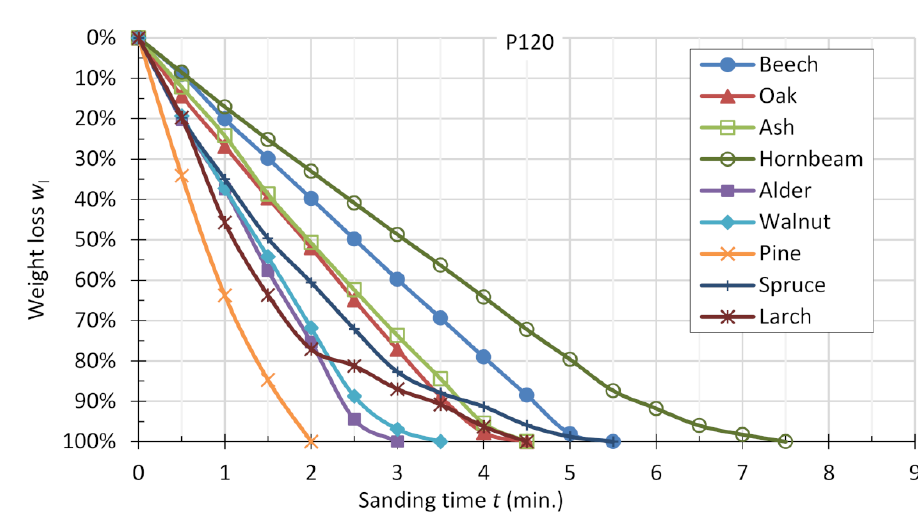
Figure 7. Average percentage weight loss of specimens sanded with abrasive belt